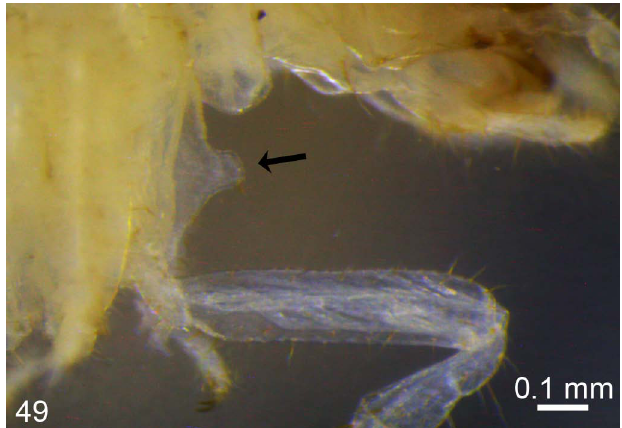
Fig 49. Forecoxa of Embiratermes neotenicus worker (arrow: lateral